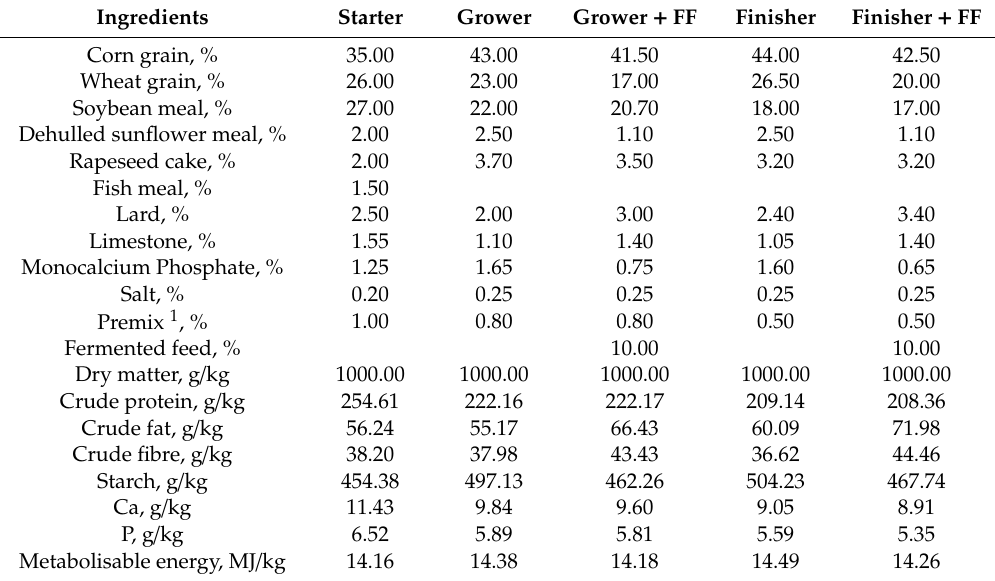
Table 1. The composition of broiler